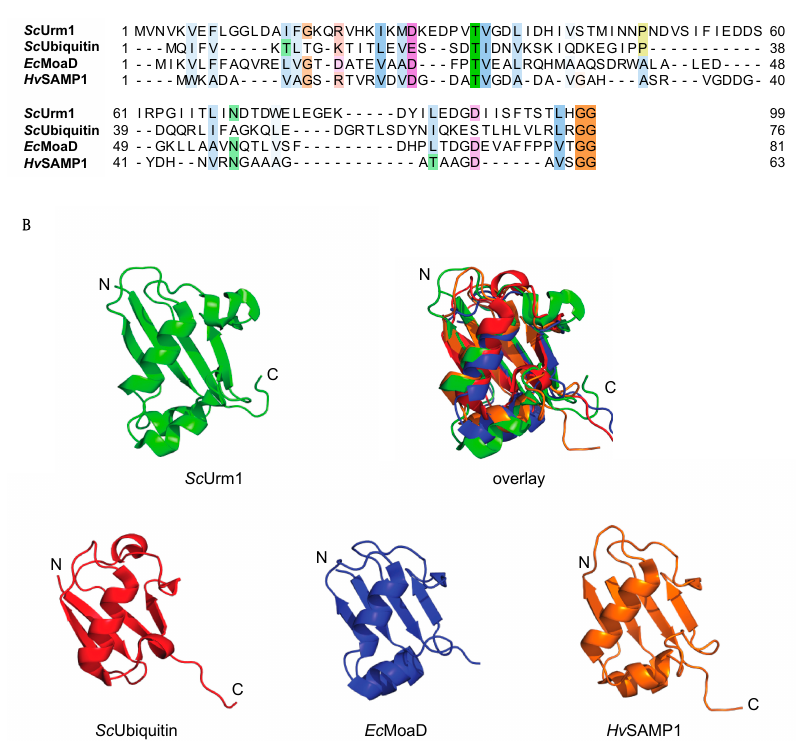
Figure 1. Comparison of Urm1, ubiquitin, SAMP1, and MoaD. ( A ) Structure-based sequence align- ment of Urm1 (UniProt entry P40554), ubiquitin (UniProt entry P0CH08) from Saccharomyces cerevisiae , SAMP1 (UniProt entry D4GUF6) from Haloferax volcanii and MoaD (UniProt entry P30748) from Escherichia coli. The degree of conservation is reflected by color intensity. Sequences were aligned with PROMALS3D [5] and visualized using Jalview [6]. ( B ) Richardson ribbon diagrams of the three-dimensional schematic representation of protein structures of Sc Urm1 (PDB entry 2QJL), Sc Ubiquitin (PDB entry 3CMM), Ec MoaD (PDB entry 1JW), and Hv SAMP1 (PDB entry 3PO0). Structures were superimposed and visualized using PyMol [7] and their N- and C-terminus are indicated. The Urm1-Uba4-system is not only restricted to eukaryotes, but also is found in archaeal systems. Ubiquitin-like SAMPs (small archaeal modifier proteins) were first identified in Haloferax volcanii [8–11]. The SAMP1, 2, and 3 are conjugated to their protein targets by an isopeptide bond. The SAMP-activating enzyme UbaA is critical for protein conjugation as well as sulfur mobilization during tRNA thiolation and molybdopterin